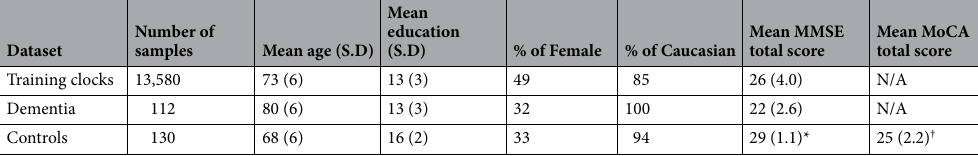
Table 1. Demographics of cohorts. S.D standard deviation, MMSE Mini-Mental State Examination, MoCA Montreal Cognitive Assessment. *This value is available only for 39 individuals in the Control cohort. † This value is available only for 91 individuals in the Control